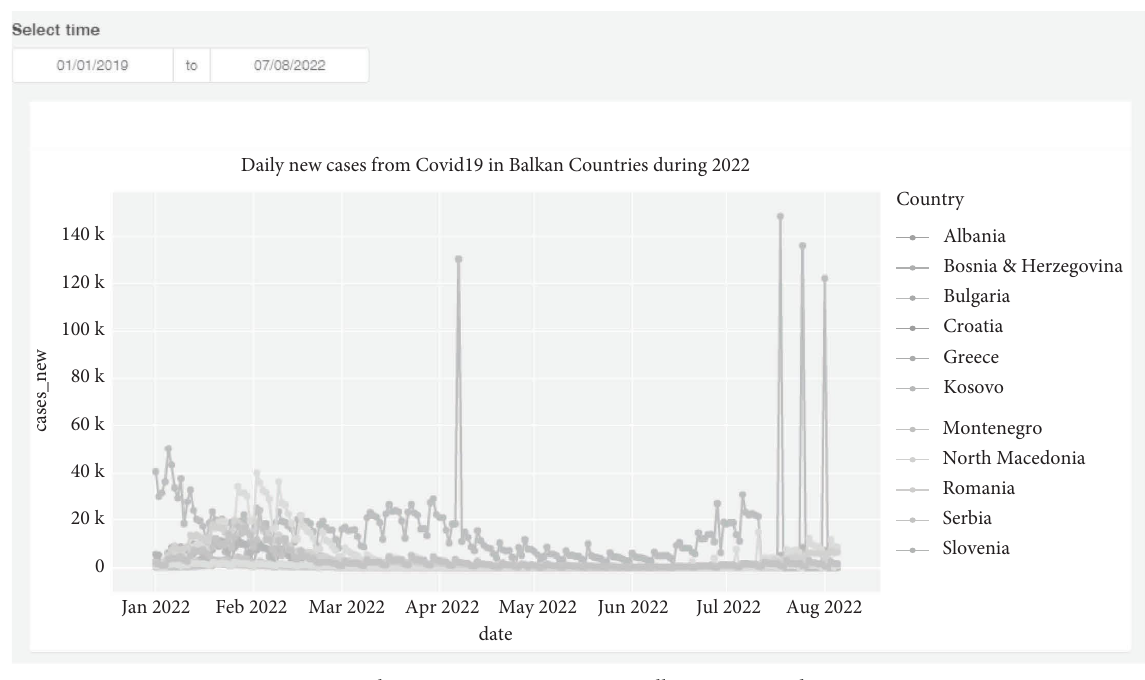
Figure 1: Daily COVID-19 new cases in Balkan countries during 2022. Daily fatalities from Covid19 in Balkan Countries since the beginning of pandemic